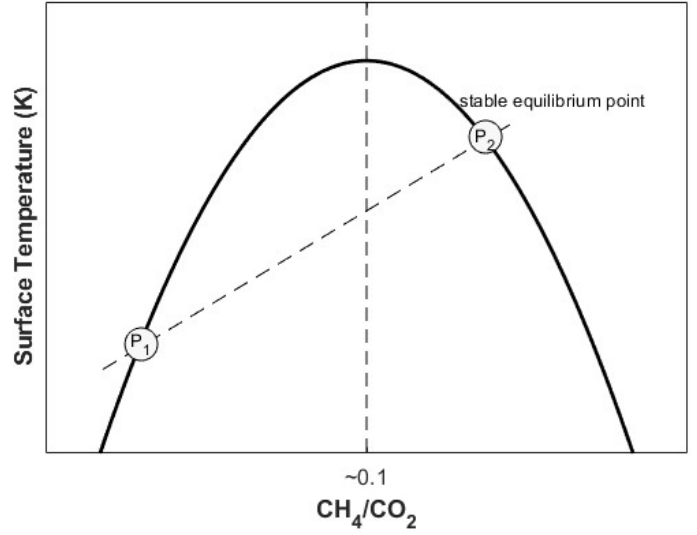
Figure 9. Proposed “Daisyworld” scenario for planets at the outer edge of the methane HZ with CH 4